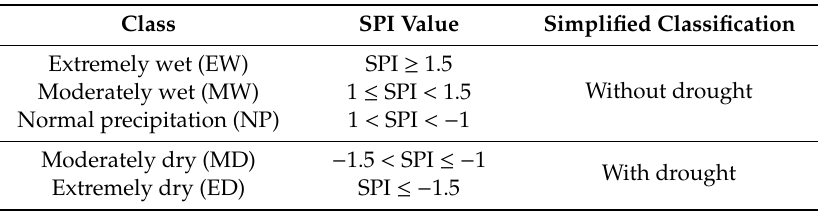
Table 1. Classification of rain anomaly according to the standardized precipitation index (SPI) values obtained using Equation (6) or (7) (modified from [27]).